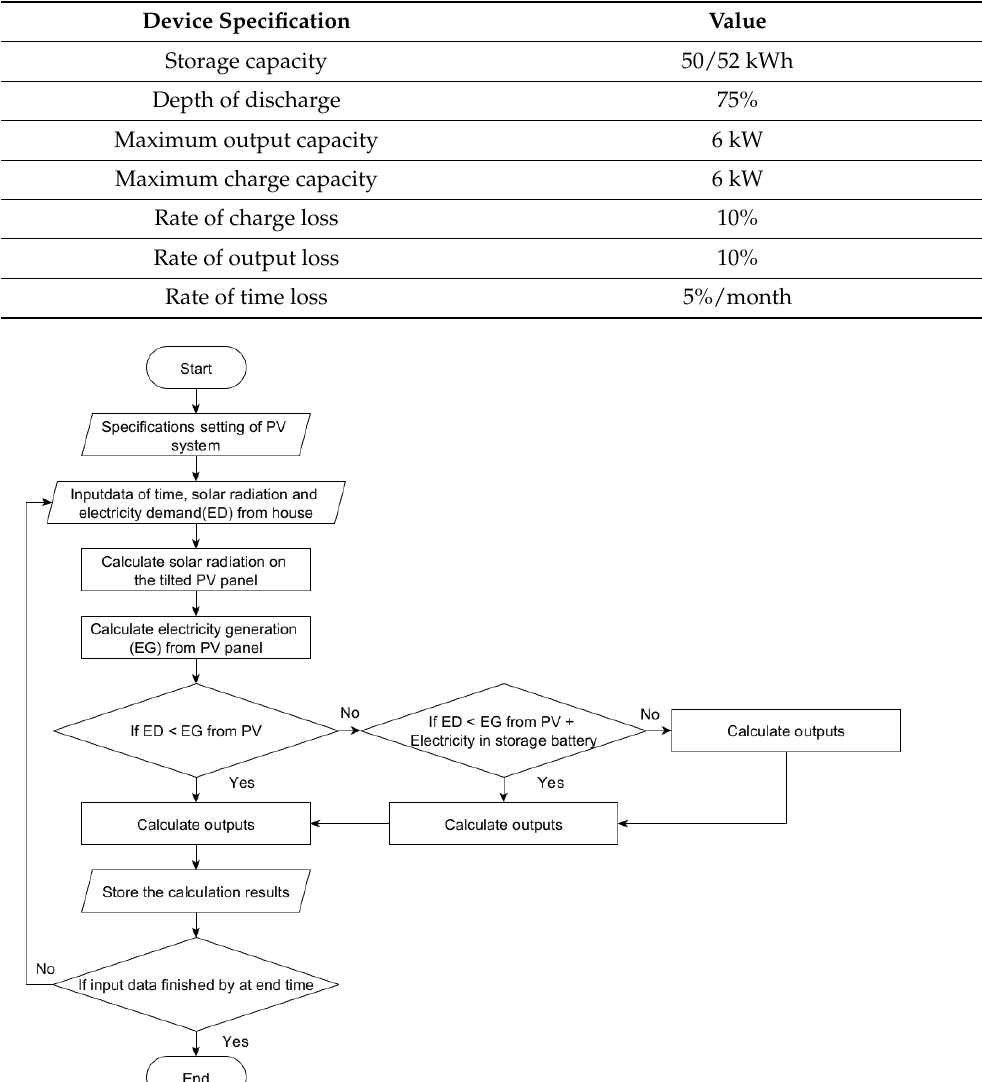
Table 9. Input parameters of the program (Storage Battery).